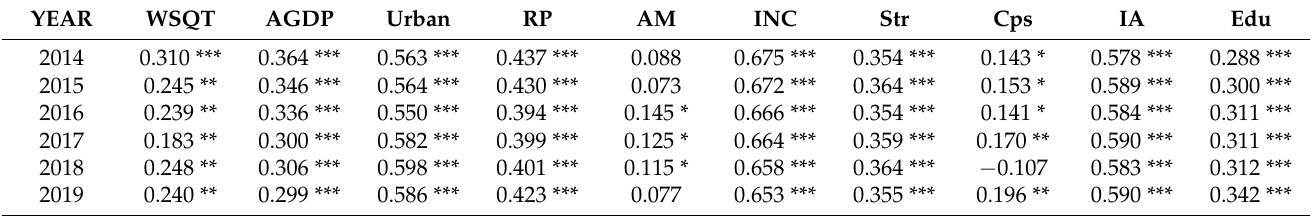
Table 7. Global Moran Index of the Agricultural Greenhouse Gas Emissions and Influencing Factors from 2014 to